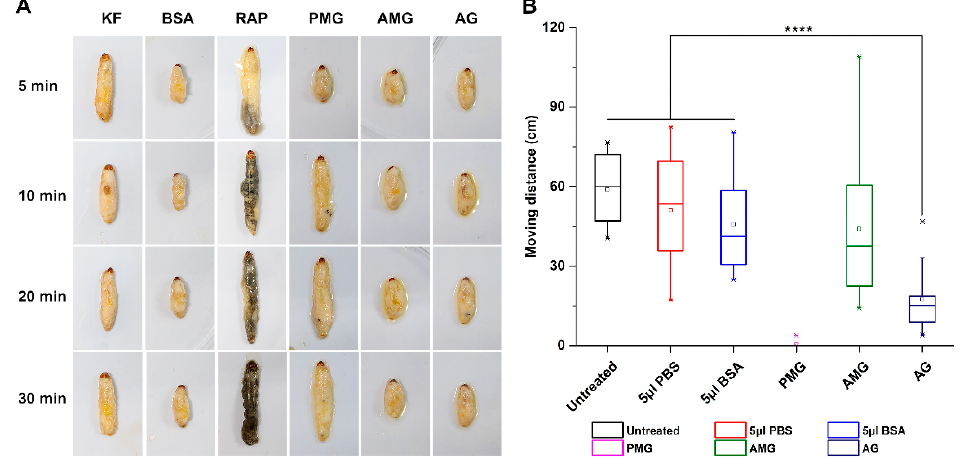
Figure 3. The bioassays of three salivary glands on Galleria mellonella larvae. ( A ) Digestive effects of each gland extract on G. mellonella larvae at different time points after injections; ( B ) the mobility activities of G. mellonella larvae after injections in 10 min. All the images are with the same magnifi- cation. AG: injection of accessory gland extracts; AMG: injection of anterior main gland extracts; BSA: injection of bovine serum albumin; KF: killing by freezing; PBS: injection of phosphate buffered saline. PMG: injection of posterior main gland extracts; RAP: the real attack by Platymeris biguttatus ; **** indicates significant differences among different treatments at p -value < 0.0001 (analyzed via one-way ANOVA).